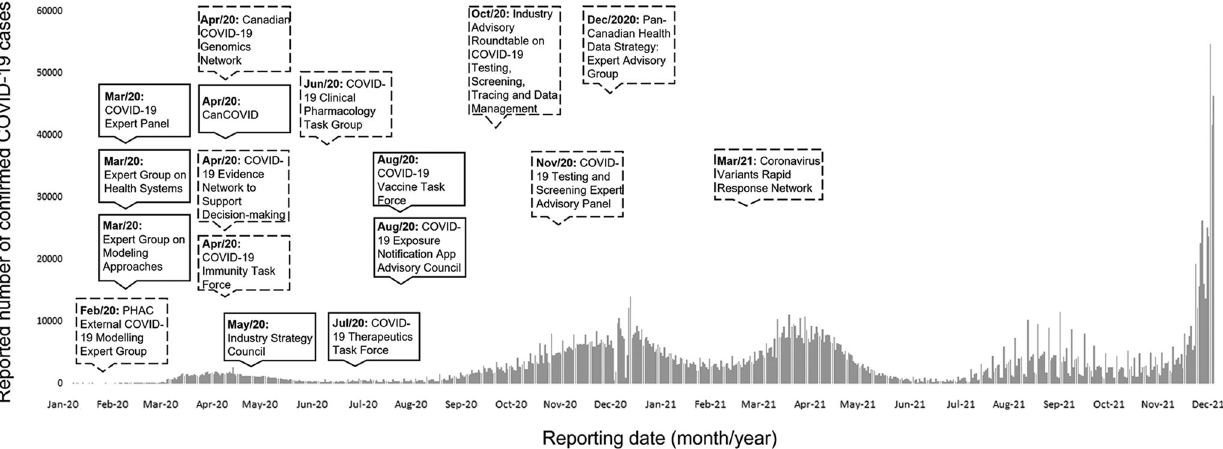
Fig. 4 Timeline of new federal science advisory bodies formed in the fi rst two years of the COVID-19 pandemic. Note: dashed borders represent bodies established by the Health Portfolio; solid borders represent bodies established by the Science Portfolio. COVID-19 case data (reporting dates: January